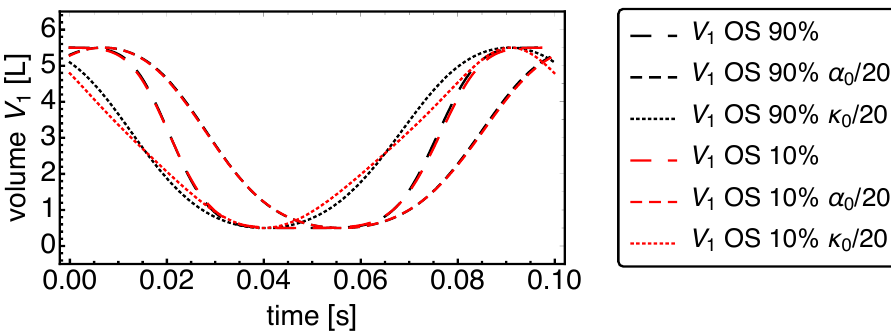
Figure 10. The optimized volume dynamics of the hot cylinder is shown as a function of time for the reference , low mass transfer and the low conductance cases with r = 10% and r = 90%. The influence of the regeneration coefficient is clearly visible, even though the impact of the different cases is much larger.